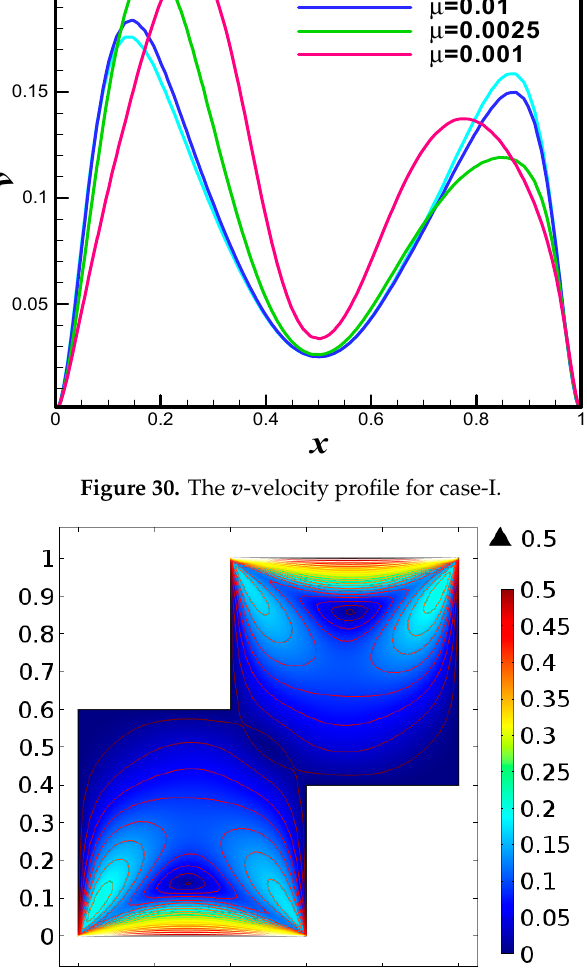
Figure 31. Velocity distribution at Re = 50 for case-III.